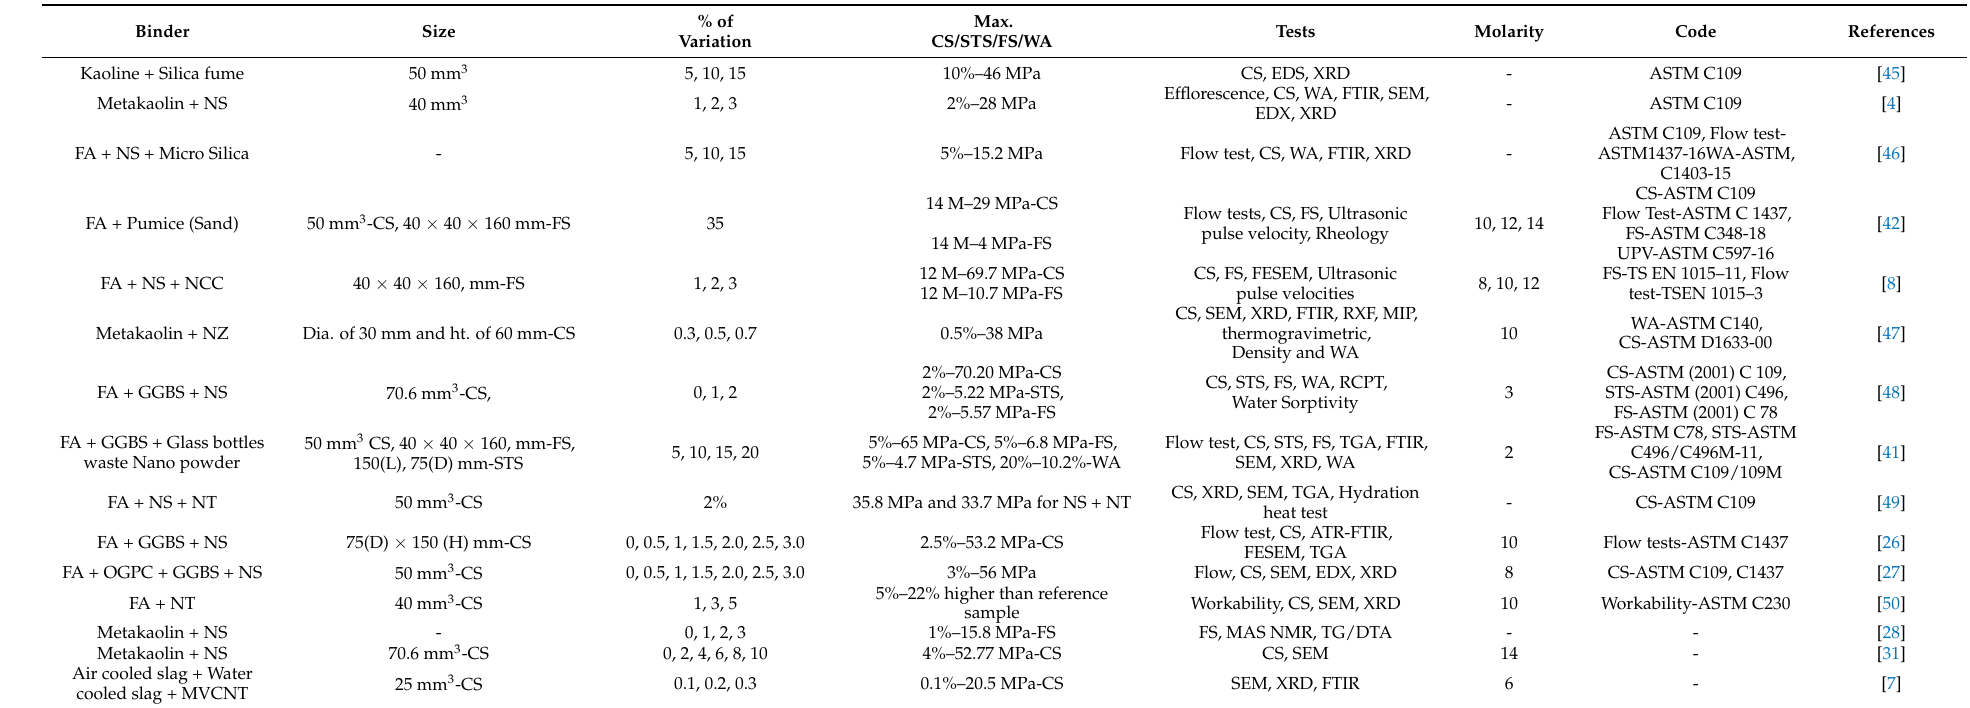
Table 1. Shows the use of nanomaterials as additives in